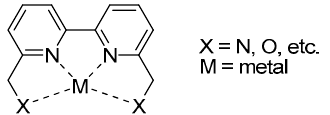
Figure 1. Multidentate chelation of metal center by 6,6’-substituted 2,2’-bipyridine.